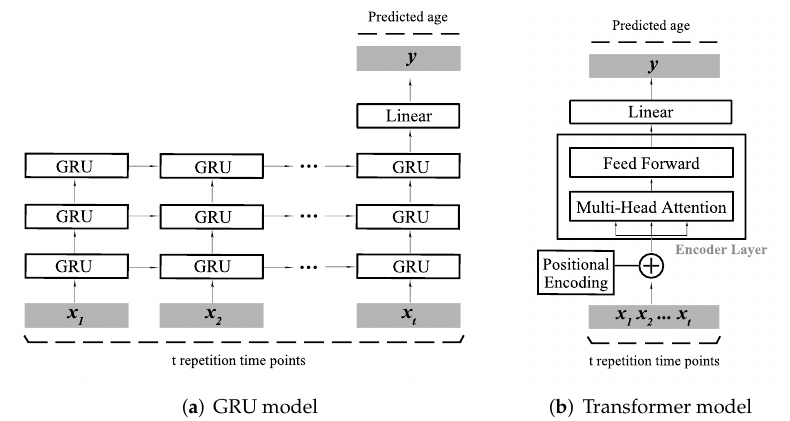
Figure 3. Schematic diagram of the model structure. ( a ) The proposed GRU-based model. The GRU module takes the preprocessed data X = ( x 1 , x 2 , . . . , x t ) sequentially as an input. The output of the last GRU module is connected to an FC layer, which is followed by the BN layer and the ReLU activation. Finally, the last FC layer estimates the age y ∈ R . All other RNN-based models have the same structure. ( b ) The Transformer-based model